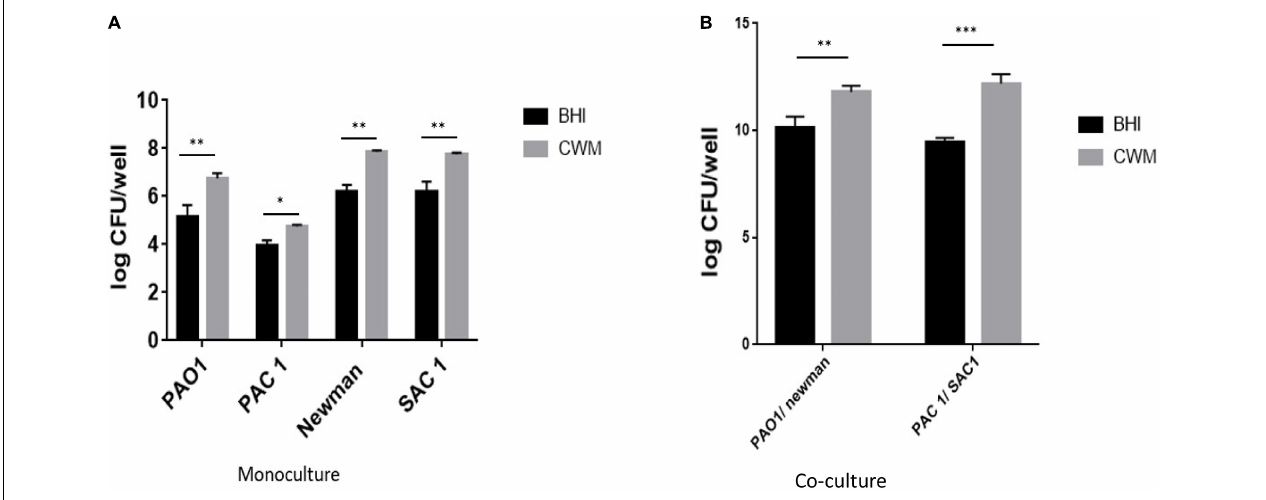
FIGURE 4 | Quantification of biofilm of S. aureus and P. aeruginosa clinical and reference strains grown in monoculture (A) or 1:1 coculture (B) . Samples were tested in triplicate in two independent experiments. Comparisons were performed with t -test. Significance was set to a p < 5%. ∗∗∗ p < 0.001; ∗∗ p < 0.01, ∗ p < 0.1.